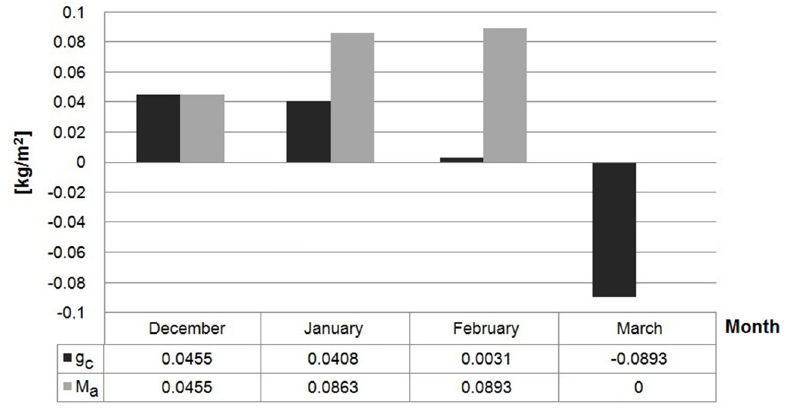
Figure 13. Streams of condensation (g c ) and accumulated moisture (M a ) in wall FH1 in the months in which condensation occurs.